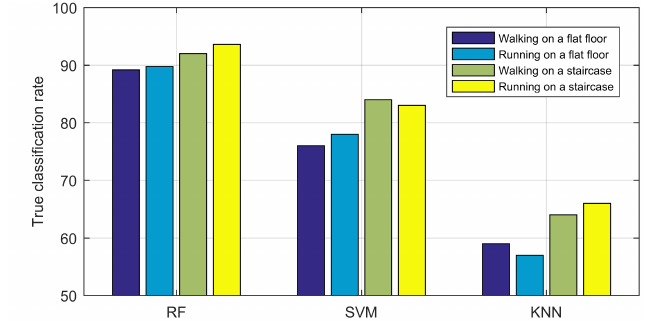
Figure 13. Intruder detection results using different